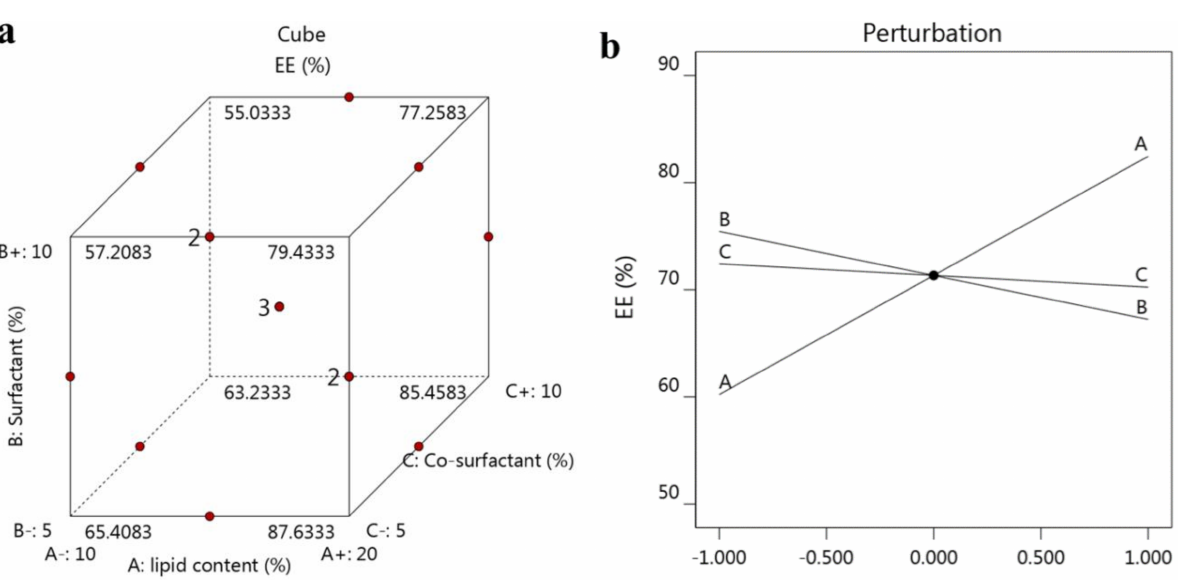
Figure 4. ( a ) Cube graph showing the predicted values and ( b ) perturbation plot displaying the influence of each independent variable alone on EE Y 2 .